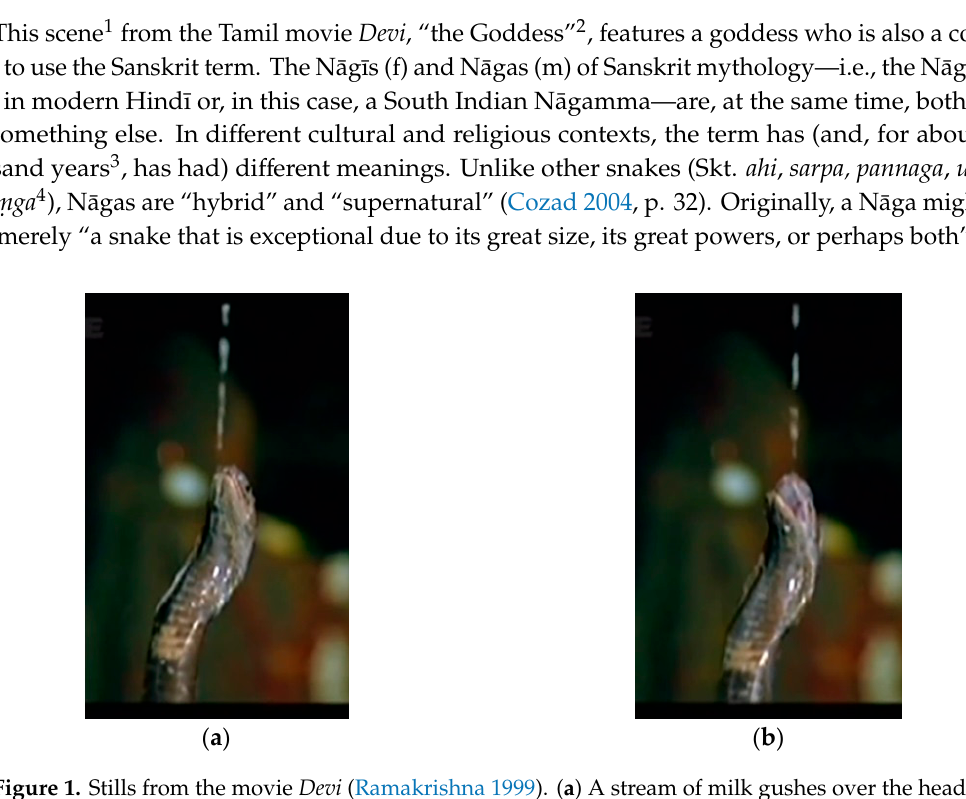
Figure 4. Mucalinda, a five- or seven-headed N ā ga king, rises like an aureole behind the Buddha, who is sitting in the lotos position ( padm ā sana ): ( a ) Brass figure from Thailand, purchased for the Marburg Museum of Religion in 1957 (photo by Heike Luu, acc.nr. Mq 027); ( b ) Gipsum replica of a Burmese figure, probably from Bagan, 11th—12th c. CE (photo by Georg Dörr, acc.nr. Mq 030; for a detailed examination on their provenience, cf. (Luu